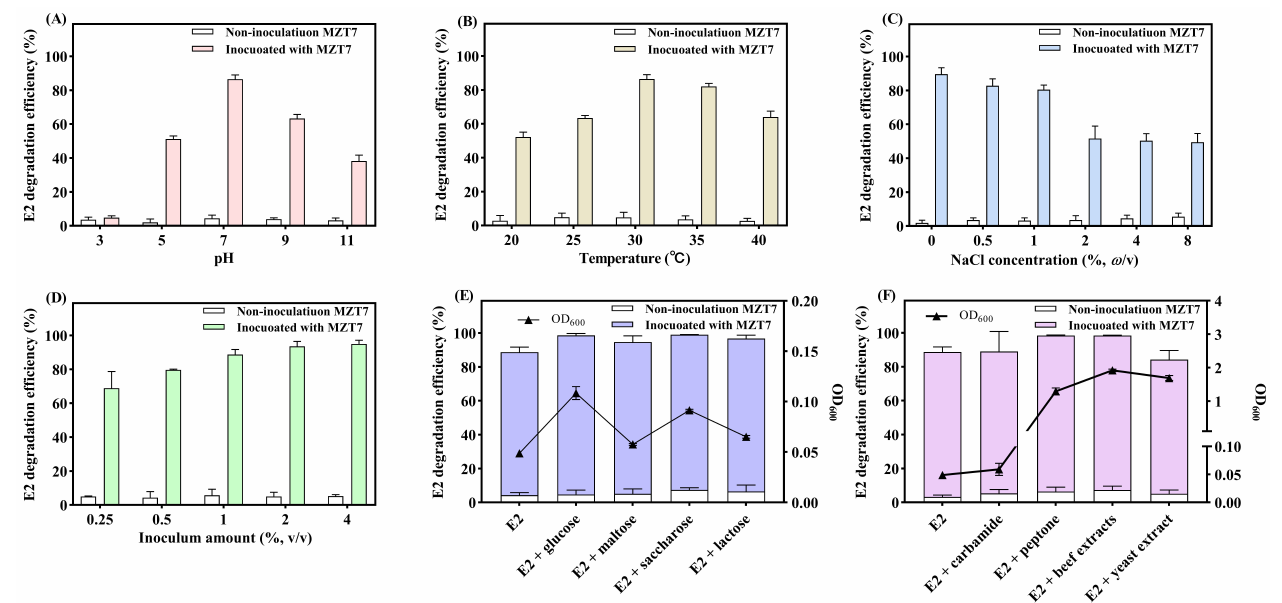
Figure 5. Effects of temperature ( A ), pH ( B ), salinity ( C ), inoculum amount ( D ), carbon ( E ), and nitrogen sources ( F ) on E2 degradation efficiency of 10 mg/L by strain